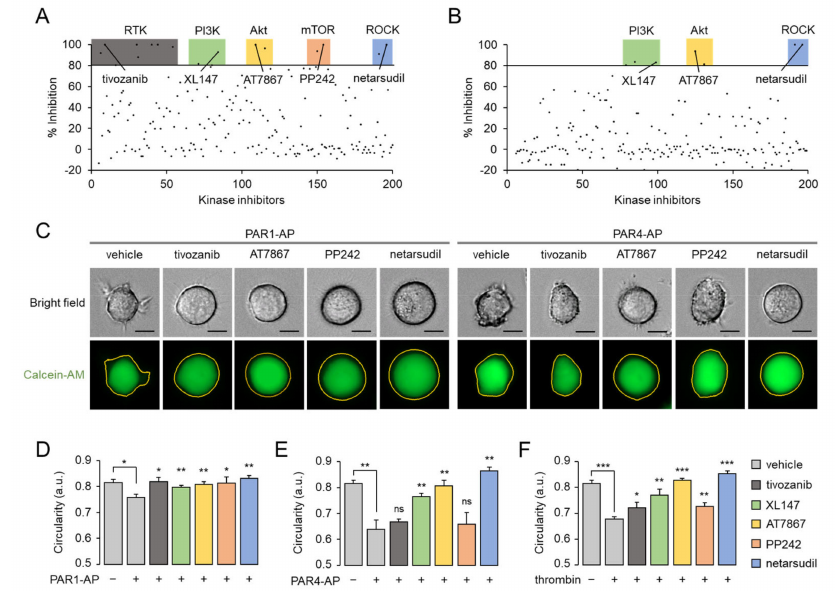
Figure 7. Identification of kinases involved in PAR1- and PAR4-mediated morphological changes in MEG-01 cells. ( A , B ) Dot plots of primary screening results for kinase inhibitors that inhibit PAR1- and PAR4-mediated morphological changes. Validated kinase inhibitors that exhibit >80% inhibitory effects on morphological changes are classified according to the class of kinase, and one representative compound for each class is indicated. ( C ) Representative images of MEG-01 cells were stained with calcein-AM (1 µ g/mL). Cells were pretreated with 10 µ M of indicated kinase inhibitors for 30 min before application of PAR1-AP (100 µ M) or PAR4-AP (100 µ M) for 30 min. Scale bar = 10 µ m. ( D – F ) Summary of circularity. Cells were pretreated with 10 µ M of indicated kinase inhibitors for 30 min and then PAR1-AP (100 µ M), PAR4-AP (100 µ M), or thrombin (0.1 U/mL) were applied. Images were taken by Lionheart automatically and circularity was measured using Lionheart software (mean ± S.D., n = 4). * p < 0.05, ** p < 0.01, *** p <